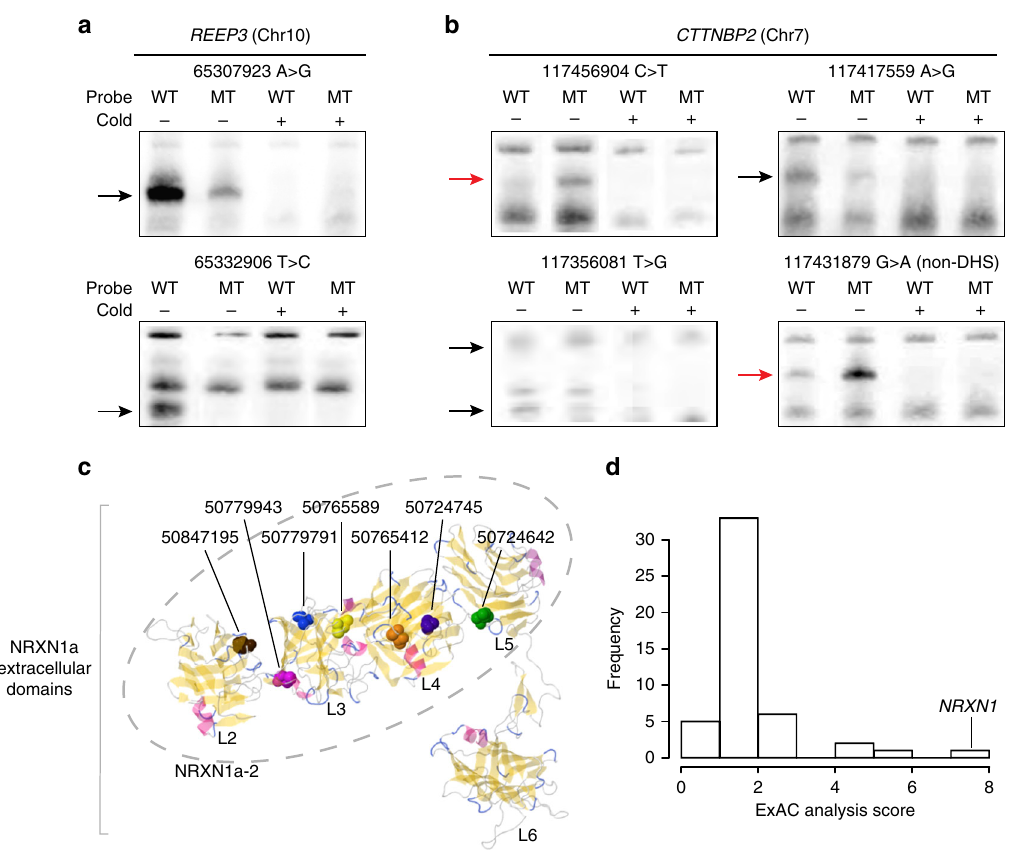
Fig. 4 Top genes validate in functional assays in context of known protein structure and in comparison to ExAC. EMSA of all 17 candidate regulatory variants in a REEP3 and b CTTNBP2 reveals that six variants either decrease ( black arrows ) or increase ( red ) protein binding when the variant sequence (MT) is compared with the reference allele (WT). The signal disappears when competing unlabeled probes (Cold+) are added, con fi rming the speci fi city of the DNA-protein binding. Raw images as well as EMSA results for experimental replicates and for other candidate regulatory variants that showed weak- binding changes are shown in Supplementary Fig. 8. c All seven of the candidate missense variants in NRXN1 , shown here as colored elements, alter the extracellular postsynaptic-binding region of our top-scoring protein isoform NRXN1a-2 43,59,60 . Of the six extracellular LNS (laminin, nectin, sex-hormone- binding globulin) domains in the longer isoform NRXN1a, fi ve with known protein structure are shown and labeled L2-L6. NRXN1a-2 includes four of these domains (L2 – L5; dashed ellipse ). d The isoform-based test comparing OCD cases to ExAC fi nds NRXN1 as the top-scoring gene with genome-wide P n O i (cid:2) E i ð Þ 2 signi fi cance. The ExAC analysis score is de fi ned as the ratio of χ 2 statistics ( , where n = total number of isoforms, O i = number of non-reference i ¼ 1 E i alleles observed in isoform i , E i = number of non-reference alleles expected from ExAC in isoform i ) between OCD vs. ExAC comparison and control